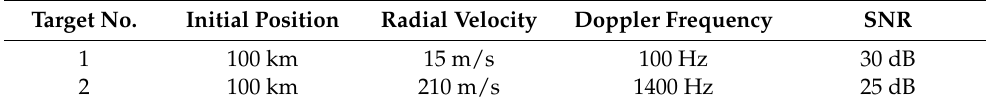
Table 7. Basic information of the targets set in Scenario 4. Target No.